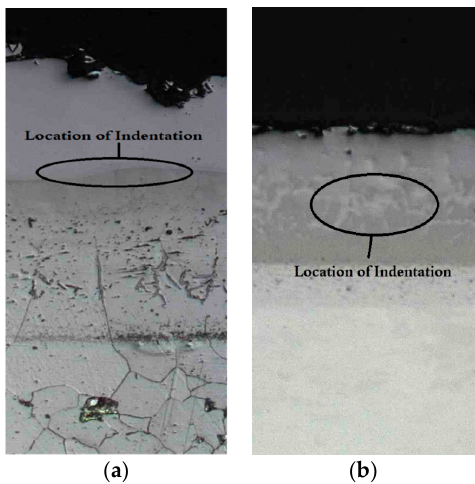
Figure 12. Location of the area where the micro-indentation hardness test was conducted for the aluminized coatings ( a ) low carbon steel, and ( b ) 316 stainless steel substrates.